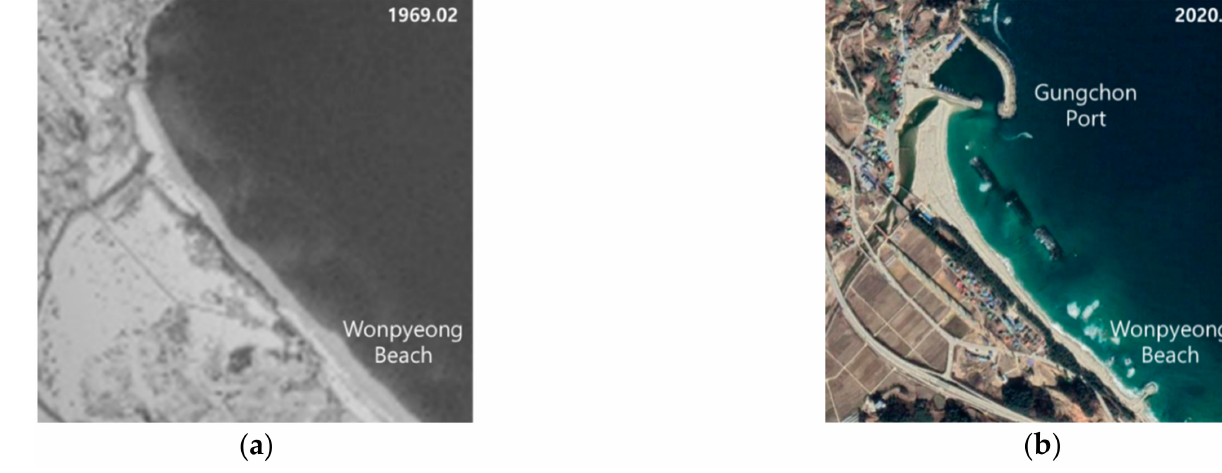
Figure 11. Changes at Wonpyeong beach before and after construction of Gungchon Port: ( a ) February 1969 (image from NGII(National Geographic Information Institute)); ( b ) February 2020 (image from Google